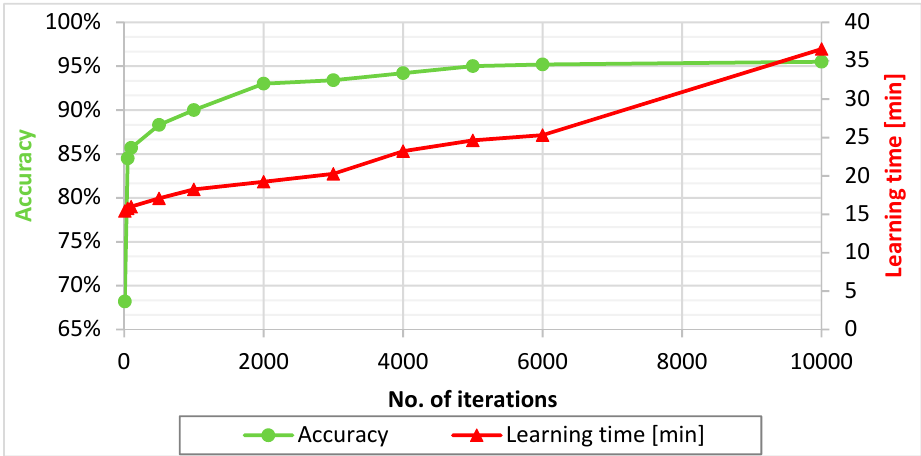
Figure 10. Graphical representation of the accuracy and the calculation time at different numbers of iterations.